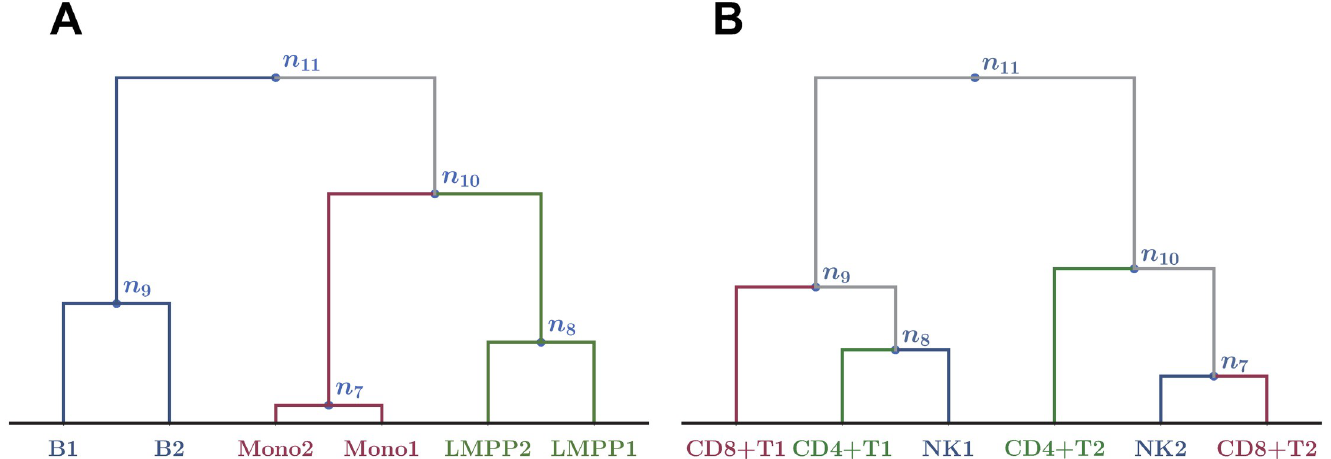
Fig 16. Examples of dendrograms with extreme penalties. Note that this dendrogram is constructed using artificial data to explain how to calculate the penalty, though we use the same labels such as Mono1. Both of these dendrograms have six leaves ( j S j ¼ 6 ) that are classified into three types (in these examples, j T j ¼ 3 ). (A) This example gives the lowest global penalty 0. (B) In this example, we have t ð CD 4 þ T Þ ¼ t ð CD 8 þ T Þ ¼ t ð NK Þ ¼ 11 . Since the corresponding cluster C set S , the local penalty is 6 − 2 = 4 for each type, and the global penalty is 4 × 3 = 12. This result gives the upper bound ðj T j (cid:0) 1 Þ � j S j ¼ ð 3 (cid:0) 1 Þ � 6 ¼ 12 in Eq (1).